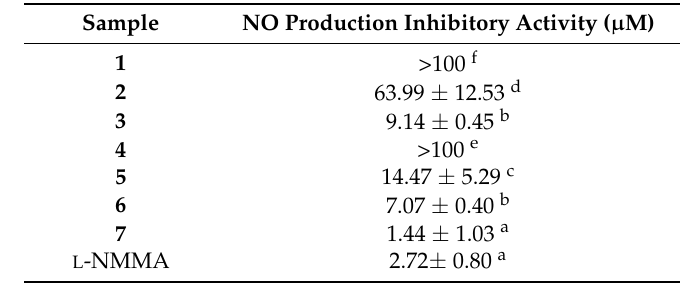
Table 3. IC 50 values of QGB compounds 1 – 7 on inhibition of NO production in RAW 264.7